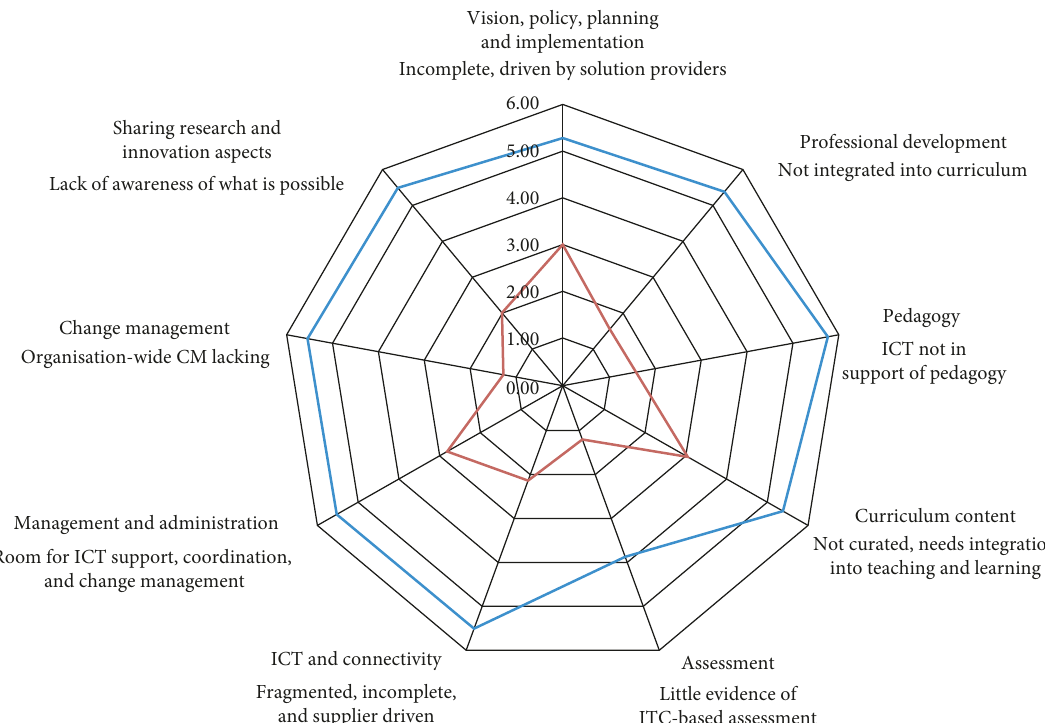
Figure 4: Dimensions of ICT in education and the associated